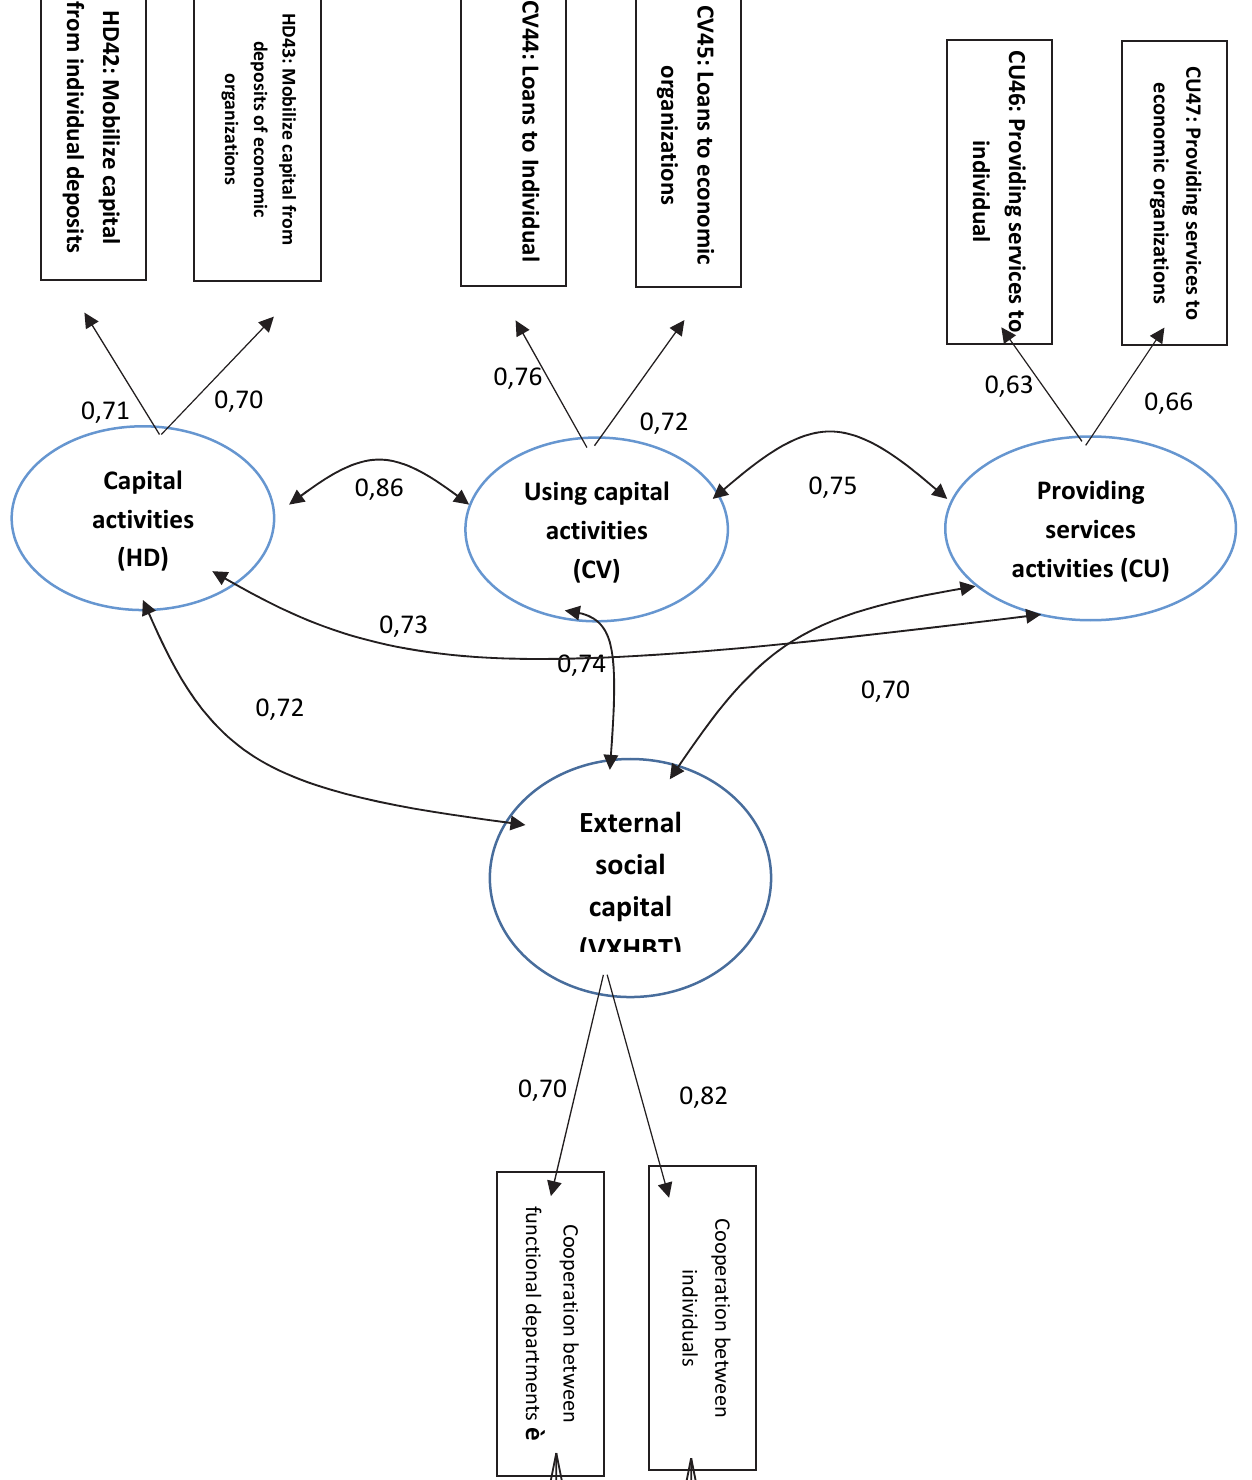
Fig. 2. CFA (standardized) between concepts in the research